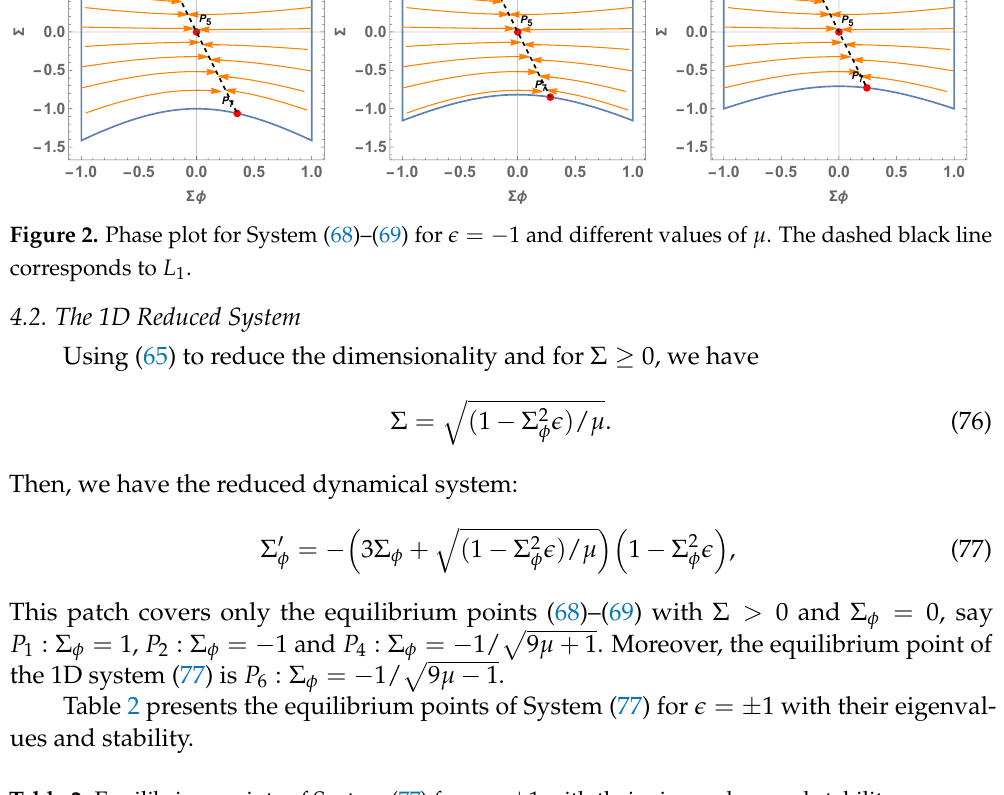
Table 2. Equilibrium points of System (77) for (cid:101) = ± 1 with their eigenvalues and stability. Label